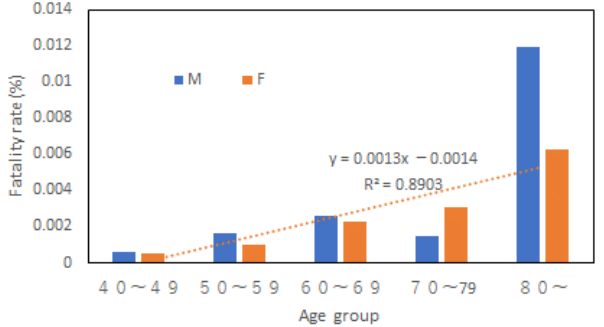
Figure 9. Fatality rates in different age groups and genders.